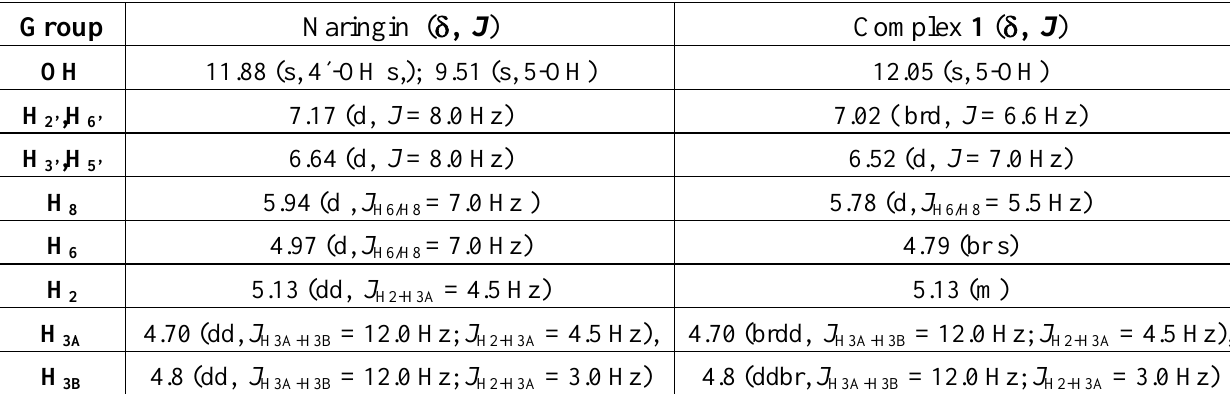
Table 2. NMR data for naringin and complex 1.